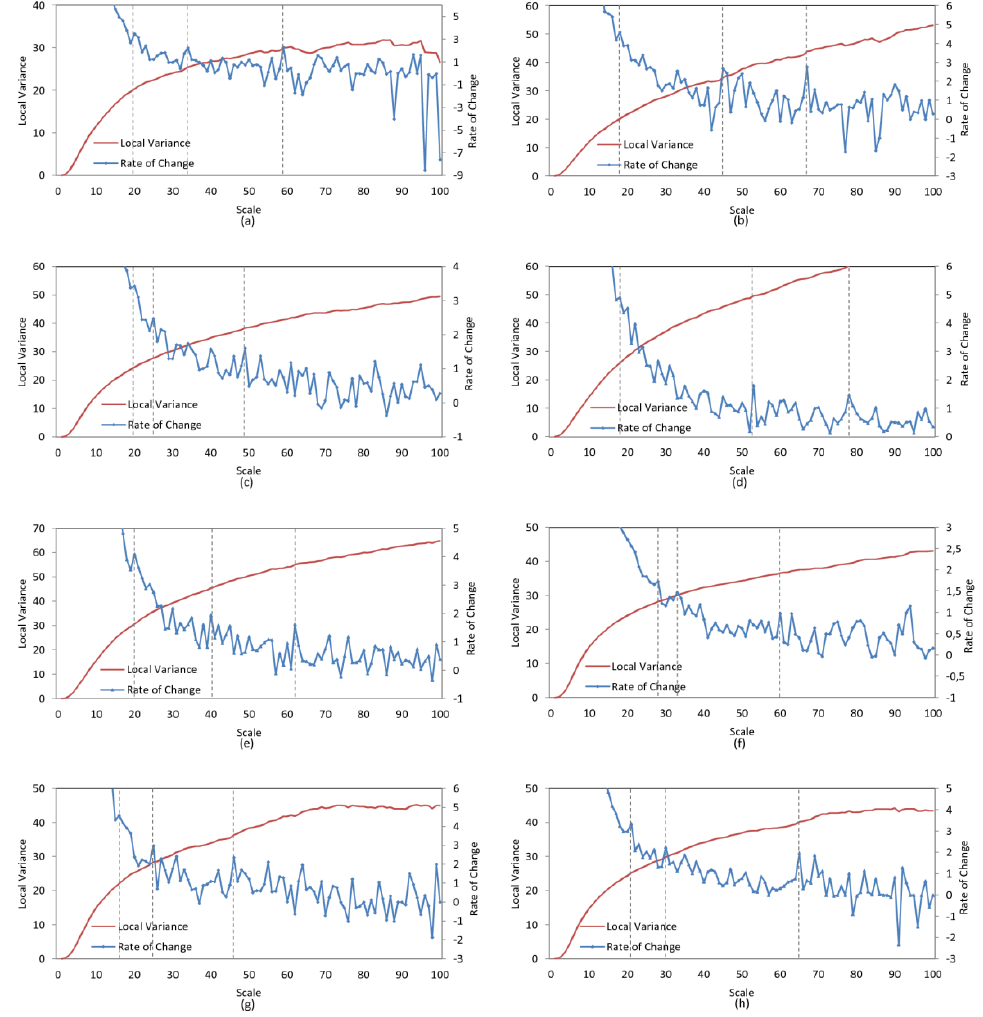
Figure 3. RoC-LV graphs of regions (a) Region 1, (b) Region 2, (c) Region 3, (d) Region 4, (e) Region 5, (f) Region 6, (g) Region 7 and (h) Region 8.